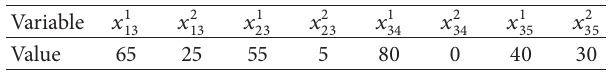
Table 5: The best solution solved by Lingo software.